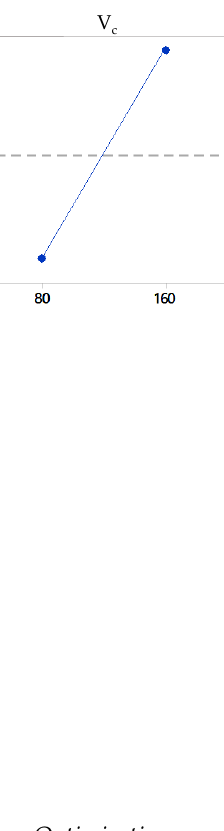
Figure 15. Pareto chart of the standardized effects for burr height.